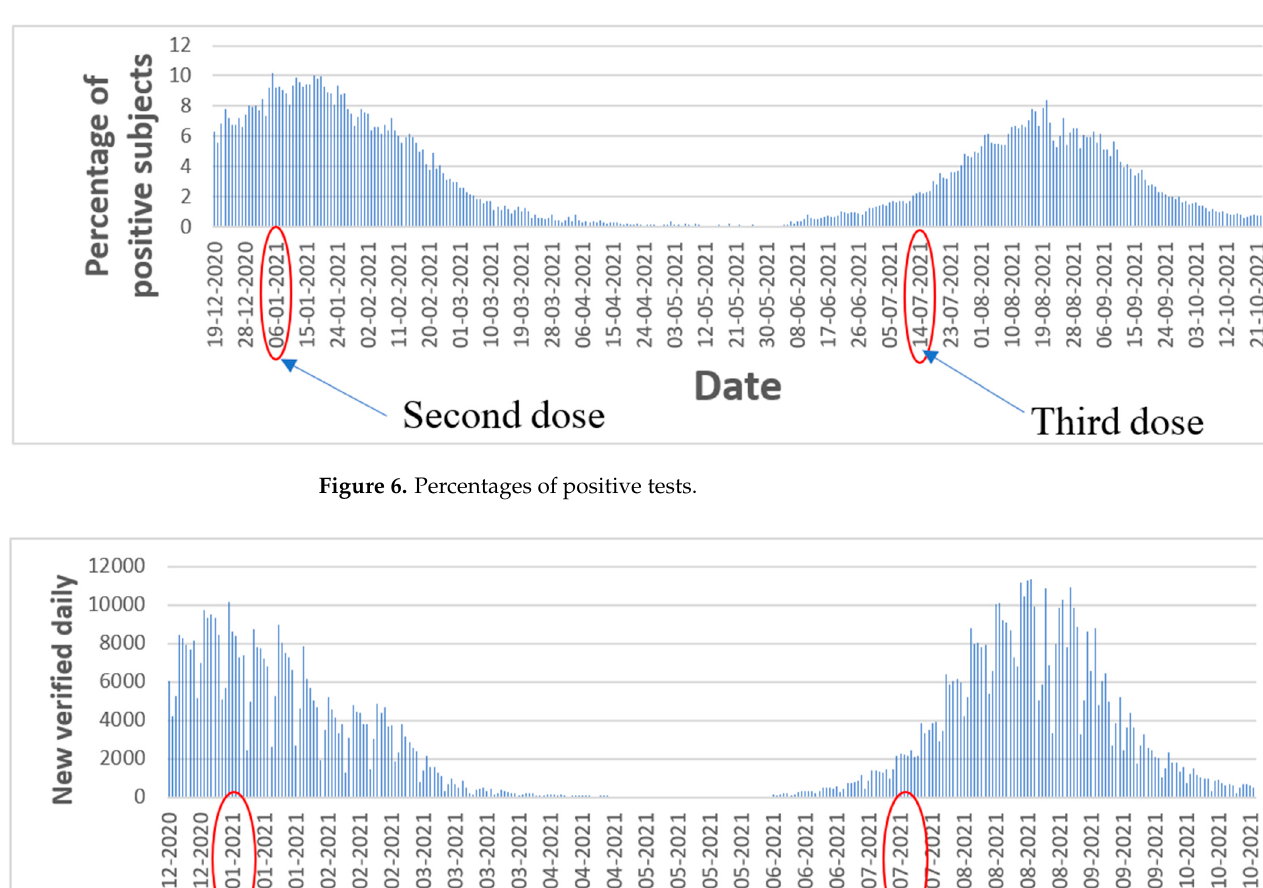
Figure 6. Percentages of positive tests.